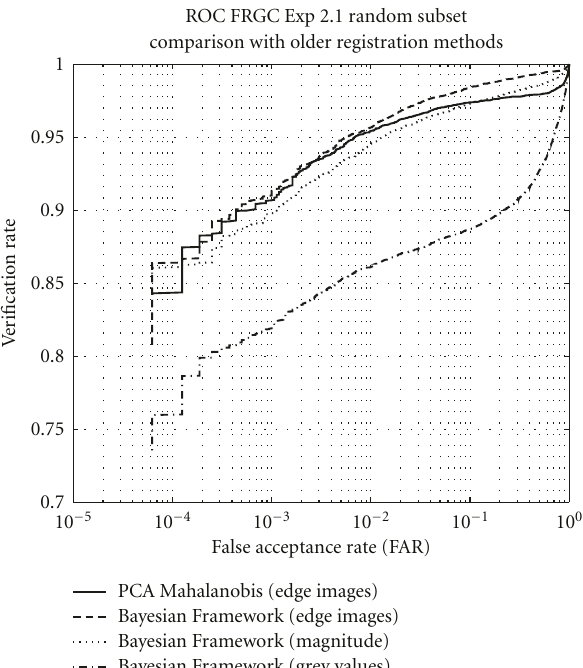
Figure 7: Comparison of face recognition (PCA-LDA likelihood ratio) with several registration methods on FRGC [4, Experiment 2 . 1] using the entire set. SHR outperforms the results of face recognition with landmark based